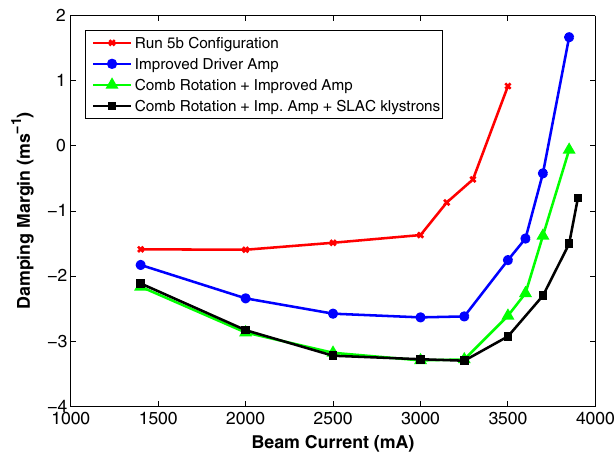
FIG. 13. (Color) Estimated damping margins at 4.5 MV.